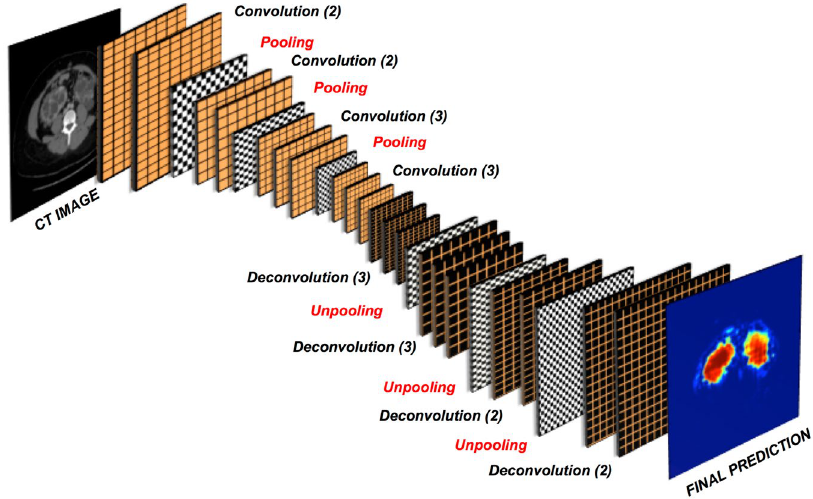
Figure 6. Fully Convolutional Neural Network Architecture. For feature extraction step, we used 10 layers of convolution filters with a receptive field of 3 × 3 and spatial padding of 1 pixel followed by max pooling layers with 2 × 2 pixel window and stride of 2 pixels to progressively reduce the spatial size of the input after convolution step. To achieve pixelwise segmentation, deconvolution and unpooling layers were used for upsampling the feature